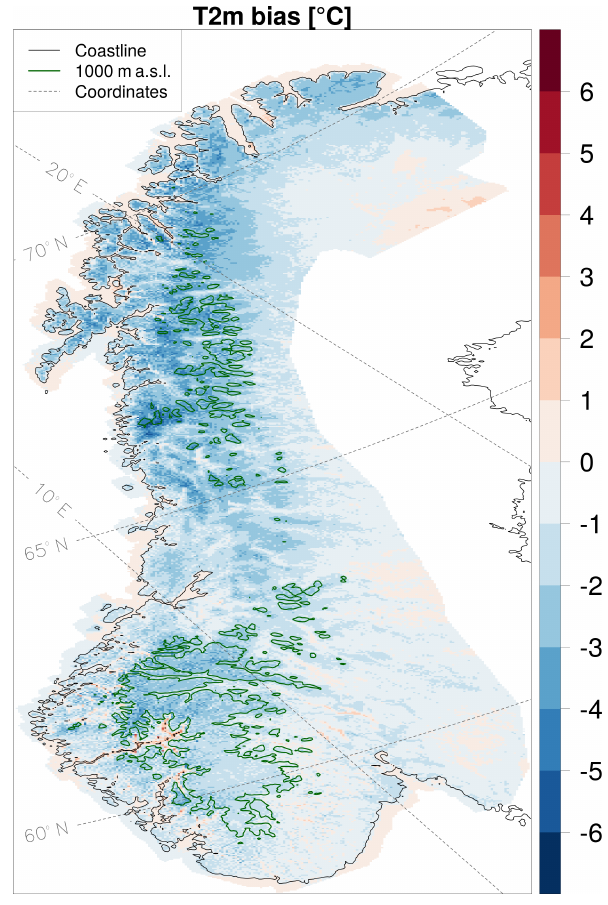
Figure 4. Annual temperature differences between HCLIM38- AROME and seNorge for the time period